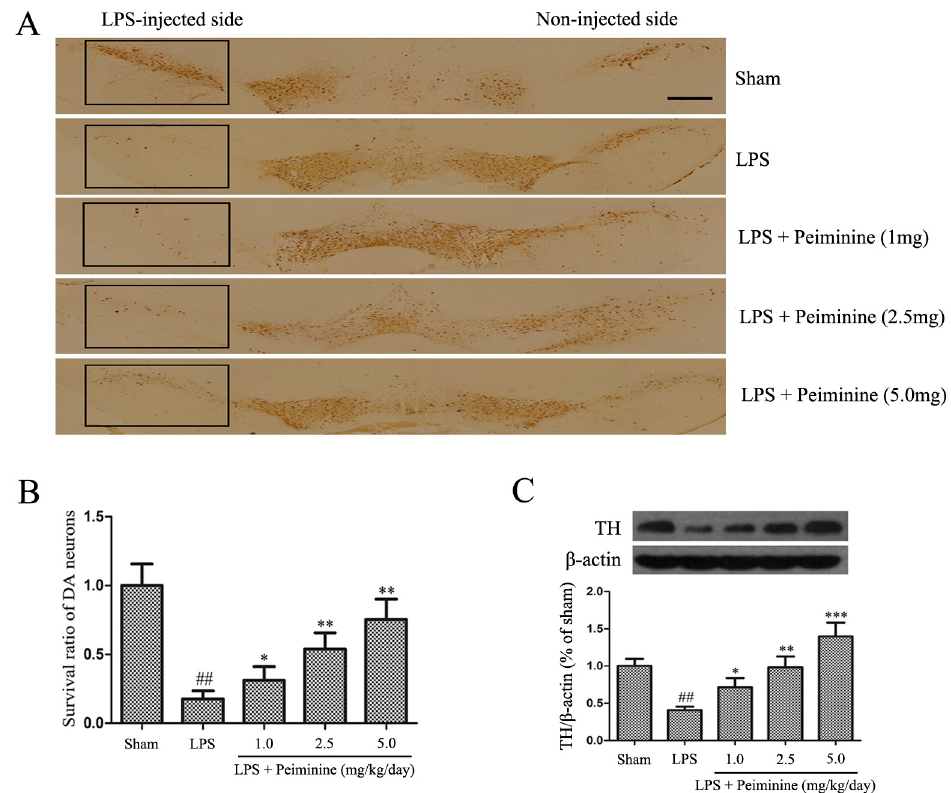
Figure 2. Peiminine inhibits the LPS-induced loss of dopaminergic neurons in the SNpc . PD model rats were decapitated on day 28 to obtain the midbrain. ( A ) Immunohistochemical staining for TH-positive cells; the magnification of the image is 4×, the scale bar represents 100 μ m ( n = 4 rats per group); ( B ) Ratio of surviving dopaminergic neurons ( n = 4 rats per group); ( C ) TH expression ( n = 4 rats per group). ## p < 0.01 compared to the sham group, * p < 0.05, ** p < 0.01 and *** p < 0.001 compared to the LPS group.